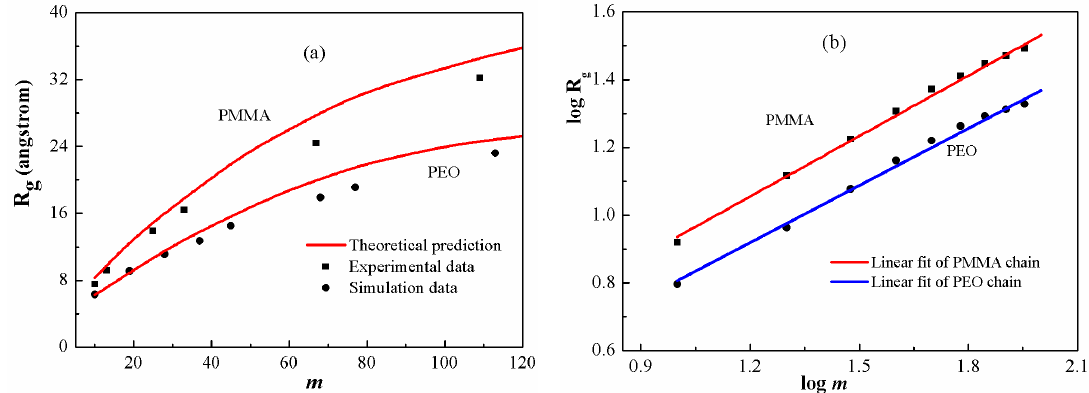
Figure 6. ( a ) Gyration radius as a function of chain length for PEO and PMMA melts at 300 K; ( b ) Determination of the scaling exponents for the two polymers. The squares and circles are calculated results and the solid line is the best linear regression.